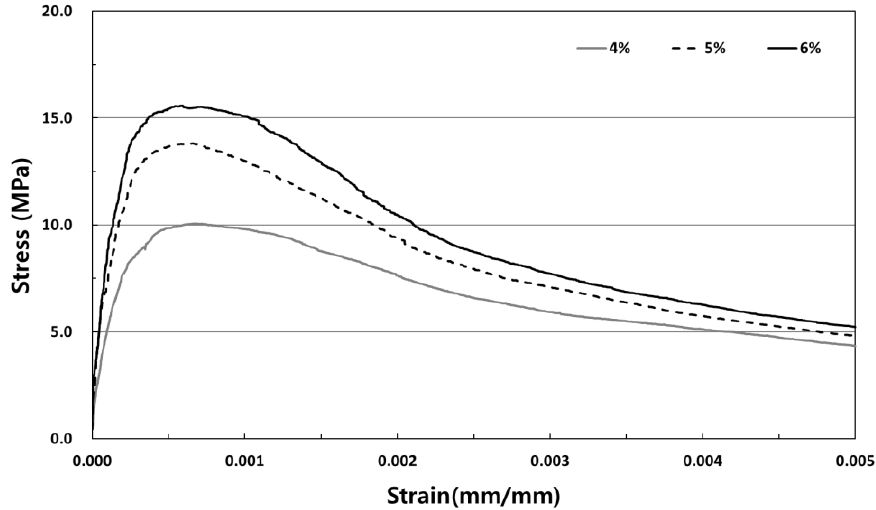
Figure 8. Tensile stress-strain curve with respect to the fiber volume fraction.